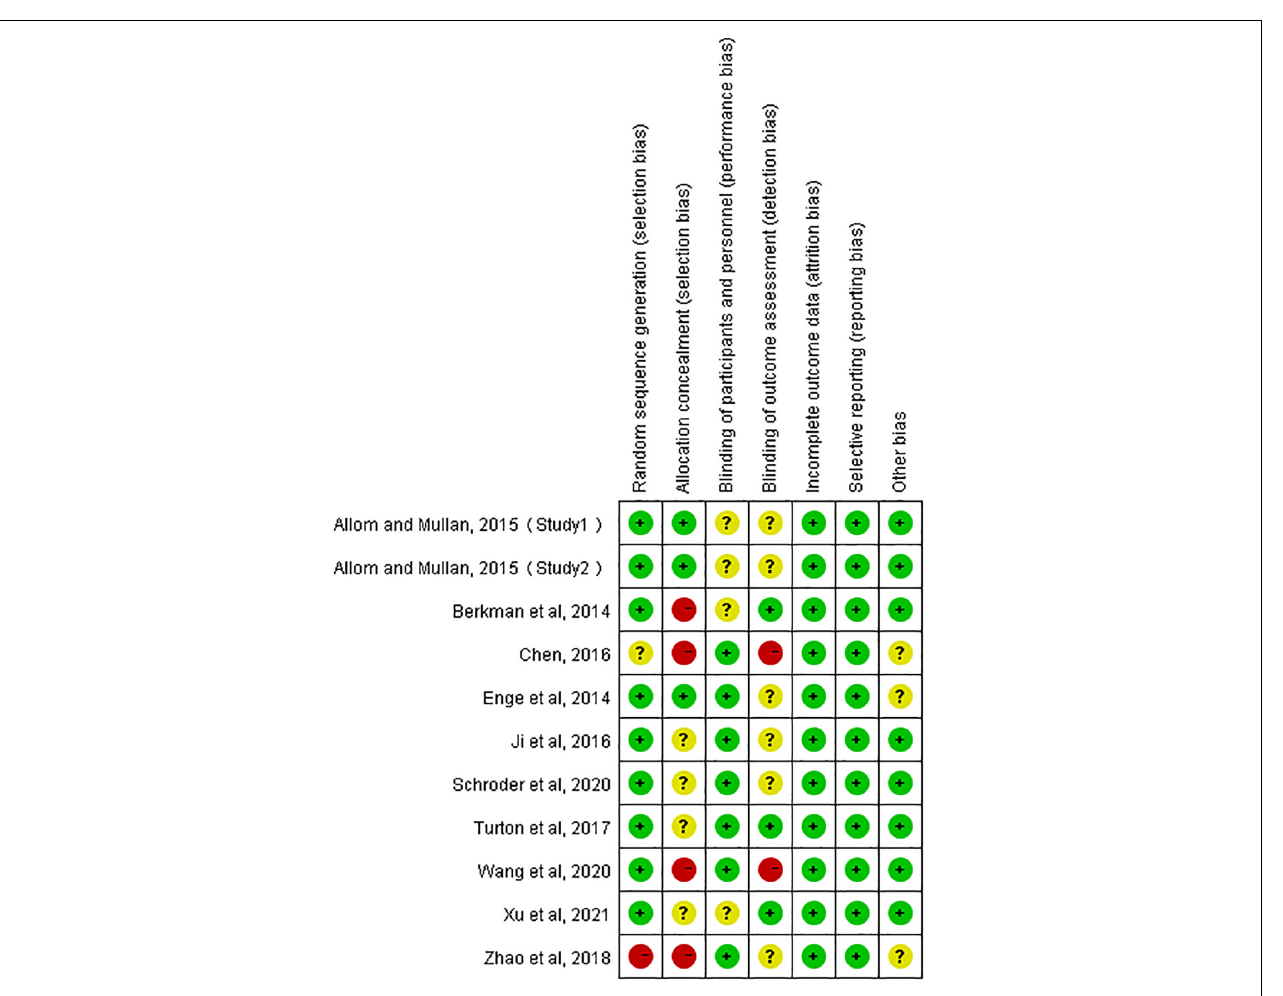
FIGURE 2 | Risk of bias summary of RCTs. +, low risk; − , high risk; ?, unclear